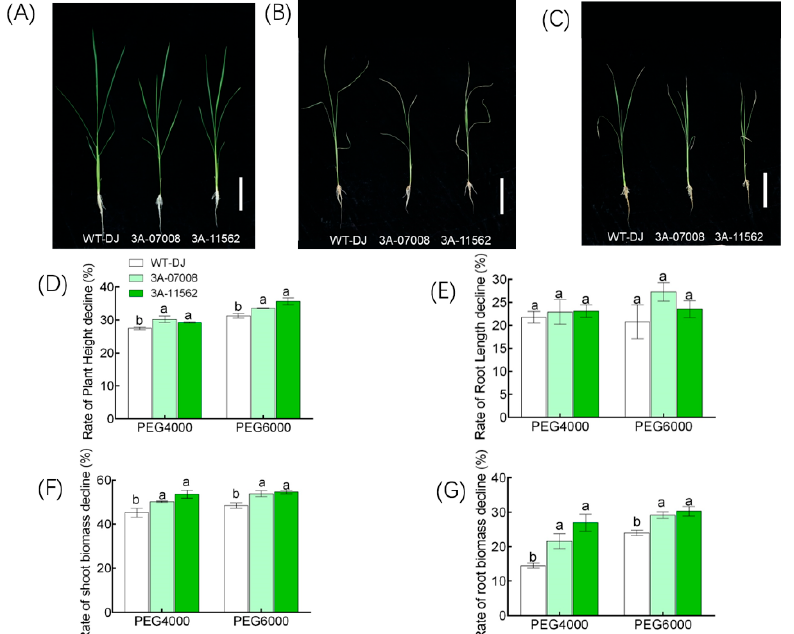
Figure 5. Phenotype of ostbp2.2 and WT-DJ at seedling stage under control and PEG treatment. Growth performance of ostbp2.2 and WT-DJ under control ( A ), 15% PEG4000 ( B ) and 15% PEG6000 ( C ). ( D ) Rate of plant height decline in ostbp2.2 and WT-DJ between control and PEG treatment (PEG4000 and PEG6000 treatment). ( E ) Rate of root length decline in ostbp2.2 and WT-DJ between control and PEG treatment. ( F , G ) Rate of dry weight decline in ostbp2.2 and WT-DJ between control and PEG treatment, shoot ( F ) and root ( G ). Error bars: SE ( n > 3). Significant differences between ostbp2.2 and WT-DJ are indicated by different letters. ( p < 0.05).